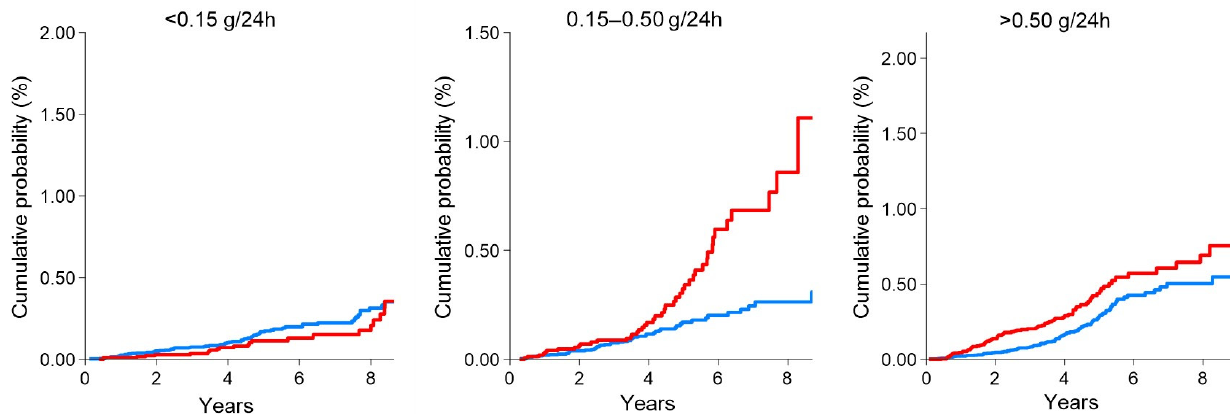
Figure 1. Cumulative probability of fatal and non-fatal cardiovascular (CV) events in DKD patients (red line) compared with non-DKD patients (blue line) by 24 h proteinuria categories. The presence of diabetes significantly increased the risk of CV events even for mild proteinuria values (0.15–0.50 g/24 h). This figure was derived from the individual data of a cohort of CKD patients followed by Nephrologists in Italy. Data from the Italian Multicohort of Chronic Kidney Disease patients followed by nephrologists (Minutolo et al.) [11]. The curves were built using the Nelson Aalen estimator of the cumulative event probability over time. p -values were: 0.208 (proteinuria < 0.15 g/24 h); <0.001 (proteinuria 0.15–0.50 g/24 h); <0.001 (proteinuria > 0.50 g/24 h).